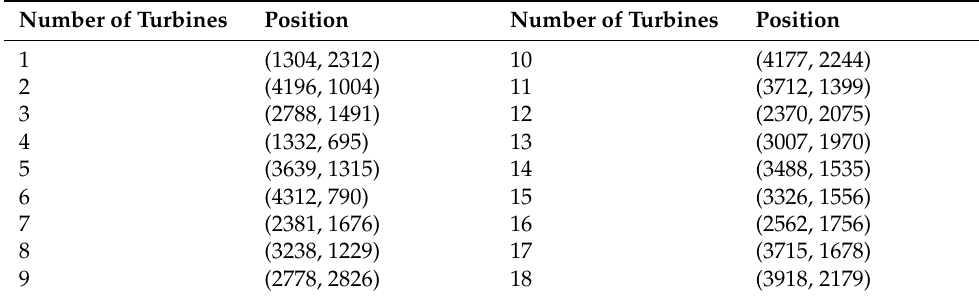
Table 5. The coordinates of 18 turbines.